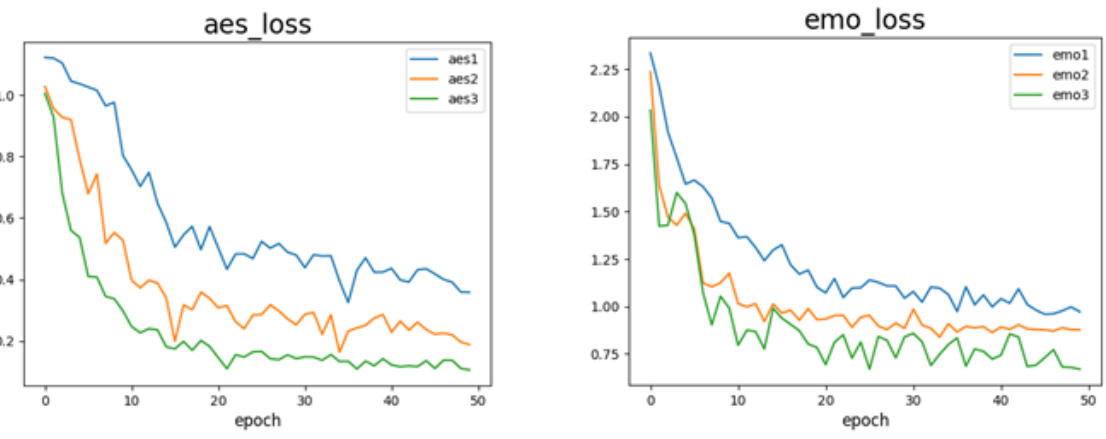
Figure 8. Visualization of intermediate